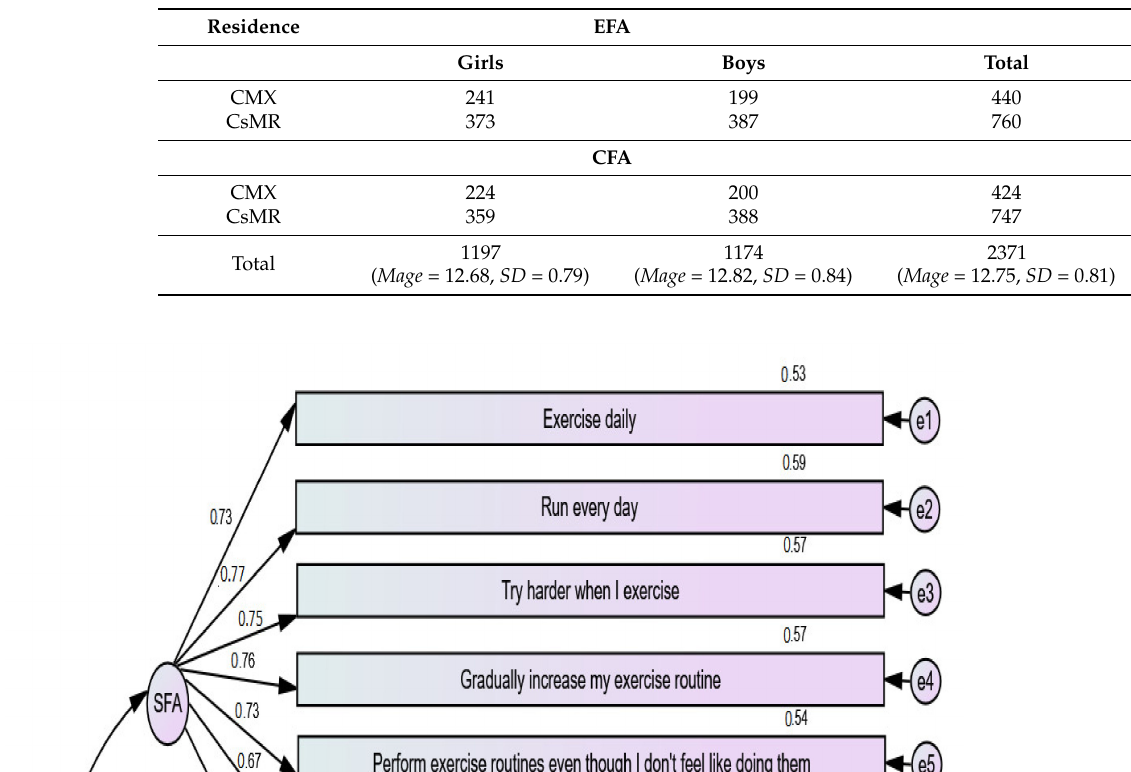
Table A1. Type of factorial analysis. Sex by residence.